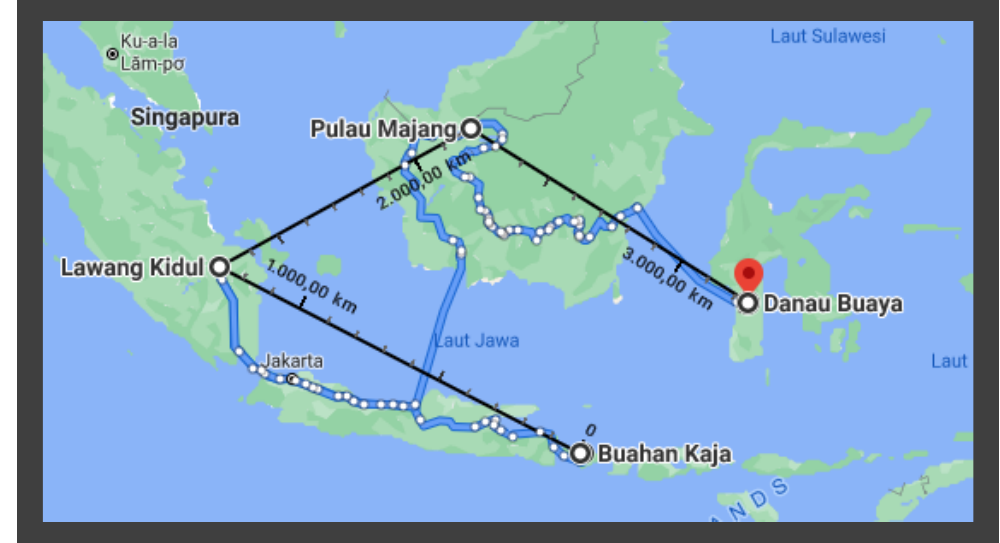
Figure 6. The distance between locations of Bali (Buahan Kaja) to Buginese (Danau Buaya) on maps using Dijkstra.